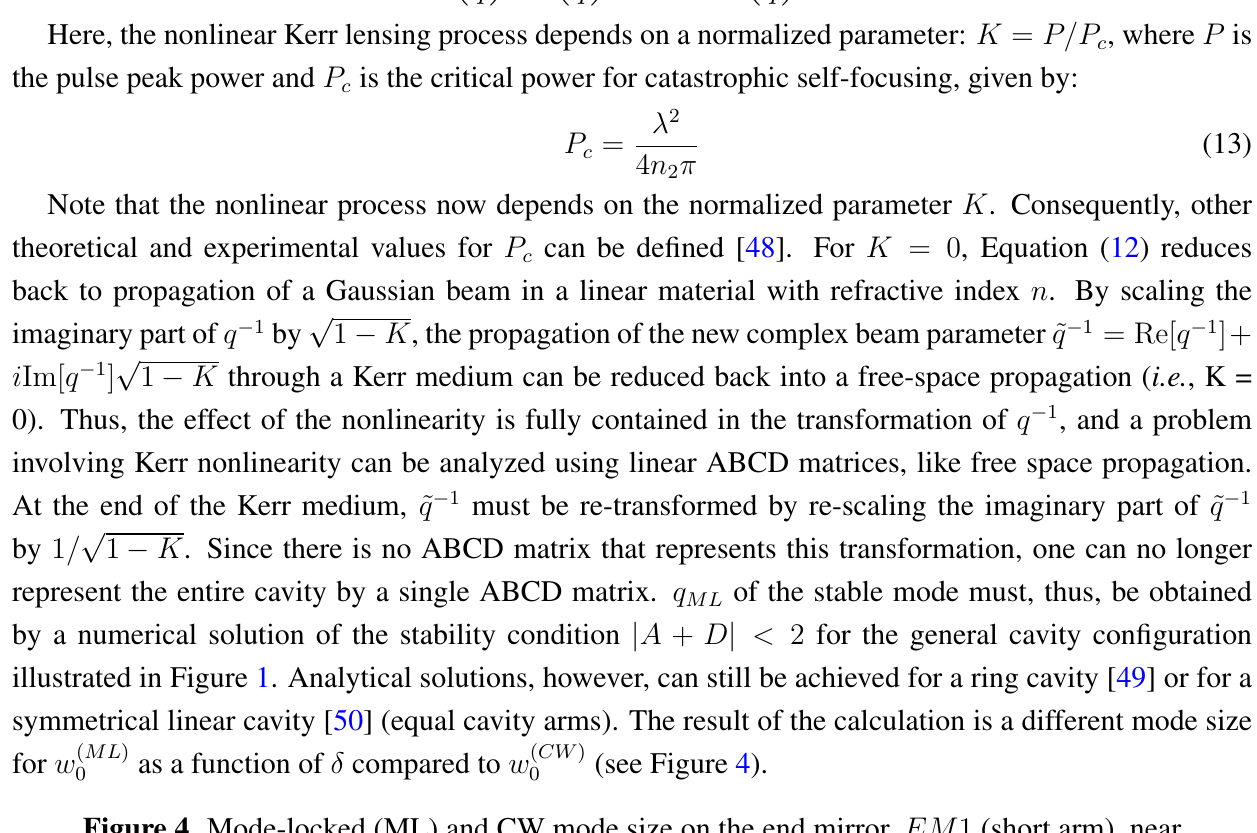
Figure 4. Mode-locked (ML) and CW mode size on the end mirror, EM 1 (short arm),